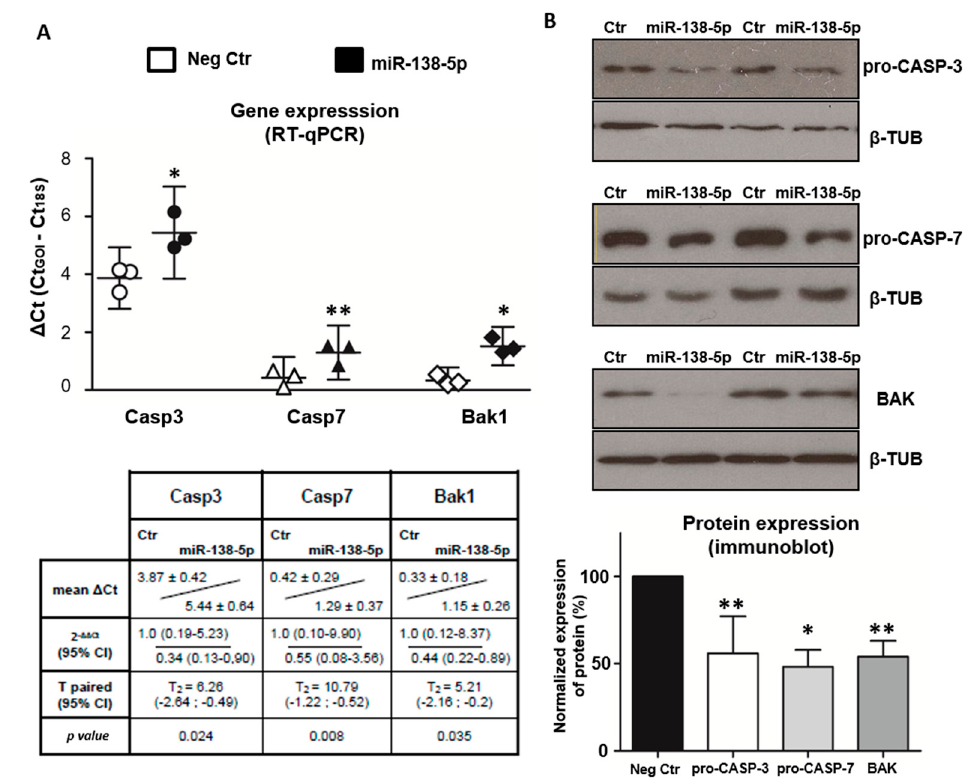
Figure 6. MiR-138-5p reduces the expression of Caspase 3, Caspase 7, and BAK: ( A ) Gene expression data from RT-qPCR analysis of C6 cultures transiently transfected with miR-138-5p or the negative control (Neg Ctr) mimics. The dot plot represents the average of Δ Ct from six independent experi- ments ± CI. Comparison between expression values was carried out through a paired t -test with ∆ Ct data ( n = 3). ( B ) Analyses of protein expression of C6 cultures transiently transfected with miR-138-5p or Neg Ctr mimics and analyzed using immunoblot and densitometry. The images represent the results of two independent replicates. The bar graph underneath shows the densitometry data of each apoptotic protein following transfection with miR-138-5p relative to their respective values after transfection with Neg Ctr, and comparisons between the two were carried out through a paired t -test. The bars represent the average ± SD of, at least, four independent experiments. Complete blot images are available at OSF (https://osf.io/yqn58/, accessed on 24 May 2022). * and ** indicate p < 0.05 and p < 0.01, respectively, relative to its corresponding negative control.